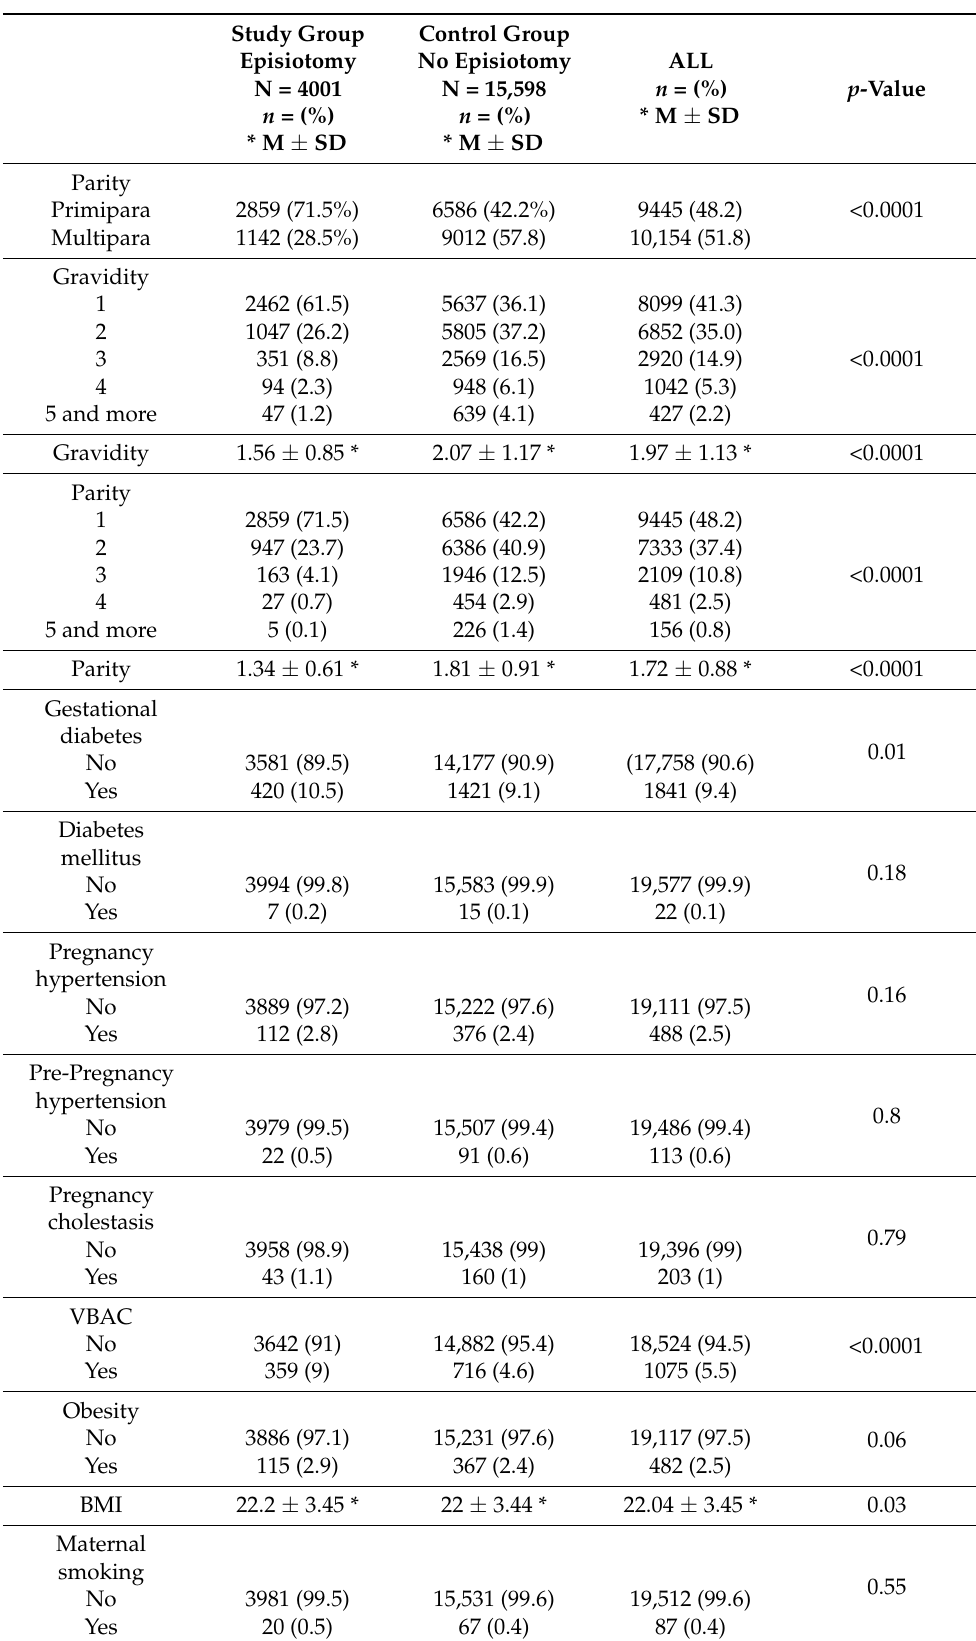
Table 2. Analysis of the incidence of perineal incisions among the selected variables occurring before